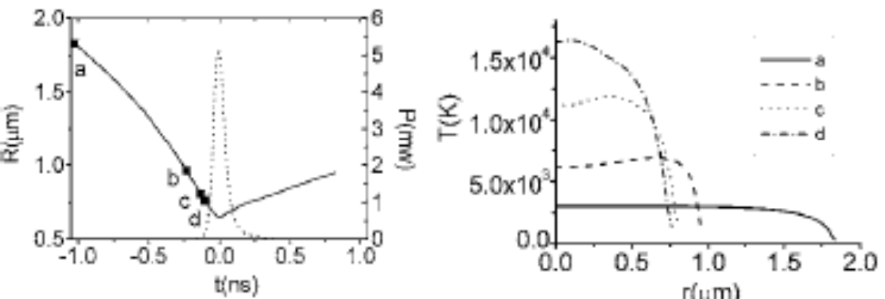
Figure 1. The results of numerical simulation of fundamental equations (PDE) for fluid mechanics inside a collapsing argon bubble under ultrasound ( left ) The bubble radius (solid line) and the optical pulse of sonoluminescence (dotted line). ( right ) The spatial profile of the calculated temperature at the given points of a, b, c, and d (filled squares in the left figure). Reprinted with permission from Ref. [109]. Copyright 2006, the American Physical Society. Figure 2. The model of bubble dynamics. Reprinted with permission from Ref. [75]. Copyright 2004, Elsevier. The demerit of ODE modeling is the accuracy of the model. ODE modeling versus PDE modeling is a trade-off between computational efficiency and physical accuracy. Thus, for ODE modeling, validation of the model is necessary by comparing with the ex- perimental data. In the present case of chemical reactions inside a cavitation bubble, the experiment of single-bubble sonochemistry is suitable for the validation of the theoretical model. In 2002, Didenko and Suslick [111] experimentally reported in Nature that the amount of OH radicals produced from a SBSL bubble was 8.2 × 10 (cid:2873) per acoustic cycle in water at 3 °C irradiated by ultrasound of 52 kHz and 1.52 bar in frequency and pressure amplitude, respectively. The number of photons of SBSL light was 7.5 × 10 (cid:2872) per acoustic cycle [111]. In order to compare with the experimental data, numerical simulations were performed under the condition of the experiment using the ODE model [74]. In the ODE model, the following effects have been taken into account: thermal conduction both inside and outside a bubble, non-equilibrium evaporation and condensation of water vapor at the bubble wall, non-equilibrium chemical reactions inside a bubble, ionization of gases and vapor inside a bubble with considerable ionization-potential lowering, variation of liquid temperature at the bubble wall, and compressibility of liquid to the first order [71– 75,112,113]. With regard to chemical reactions inside a bubble initially consisting of nitro- gen, oxygen, argon, and water vapor, rates of 93 chemical reactions and their backward reactions were numerically calculated at each moment of the bubble collapse. The main bubble content inside a SBSL bubble is argon because nitrogen and oxygen chemically